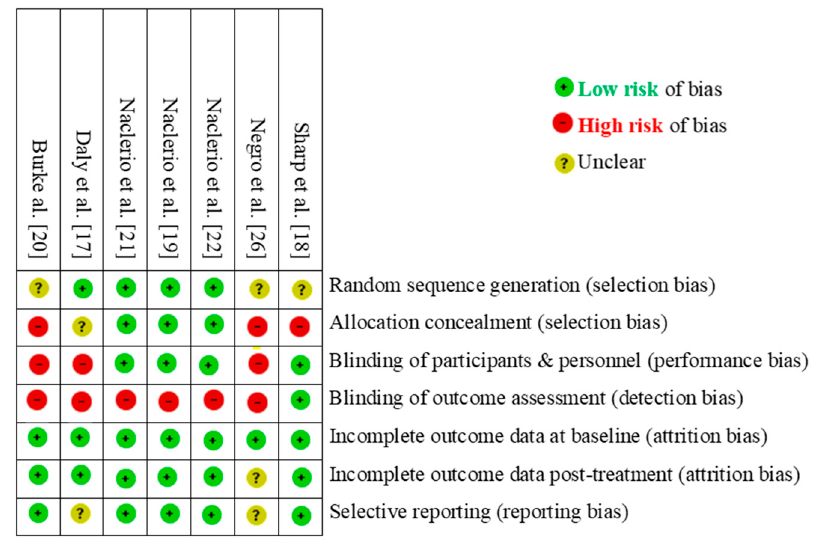
Figure 2. Quality assessment of the included studies.